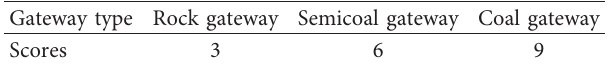
Table 4: The scores of gateway types.